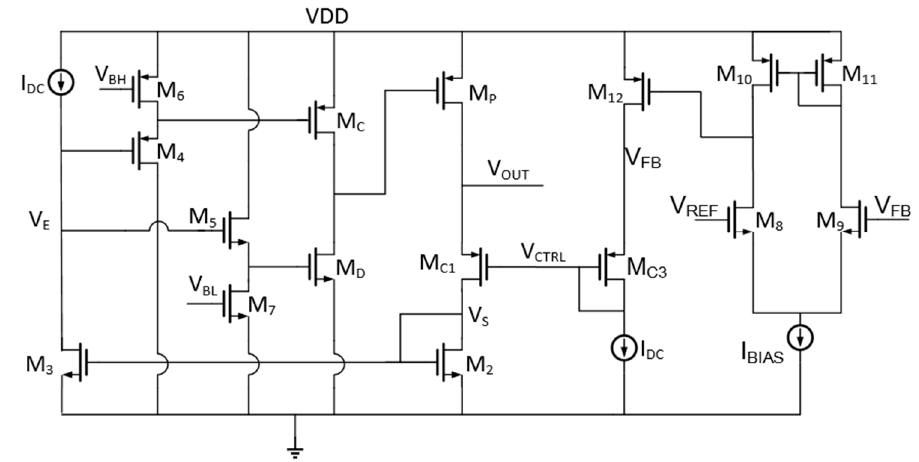
Figure 5. Full circuit diagram of the OCL-LDO with the proposed push–pull buffer.